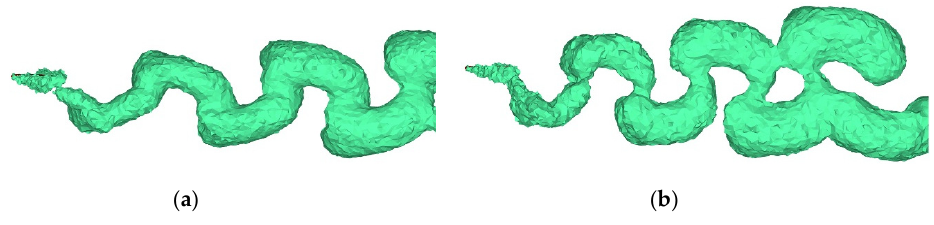
Figure 11. Vortex pattern in the wake: ( a ) α max =25°; ( b ) α max =10°.